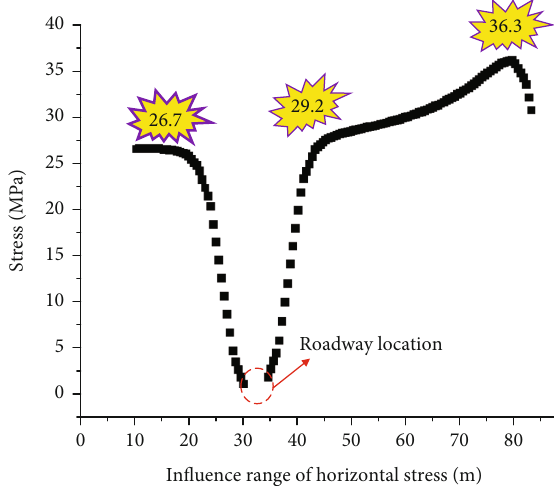
Figure 10: Horizontal stress distribution.